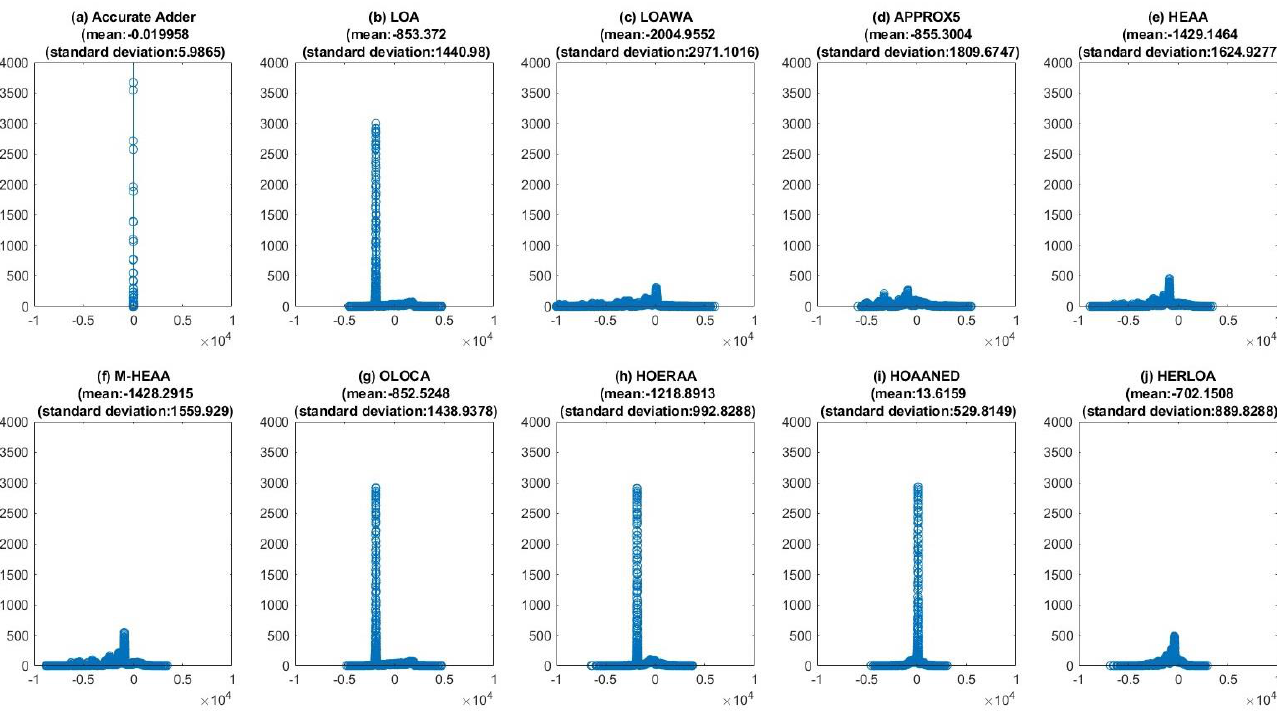
Figure 14. Plots showing the DPV between the Black Hole image compressed using accurate and approximate adders and the original Black Hole image, with the approximate adders having a 12-bit inexact part.